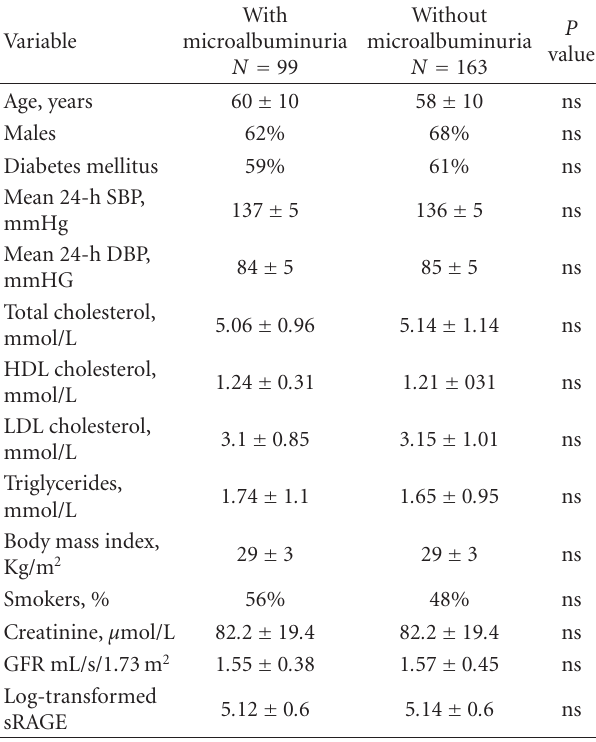
Table 1: Baseline characteristics of patients with and without mi- croalbuminuria. Continuous data are reported as mean ± SD or median (interquartile range), categorical data are presented as per group